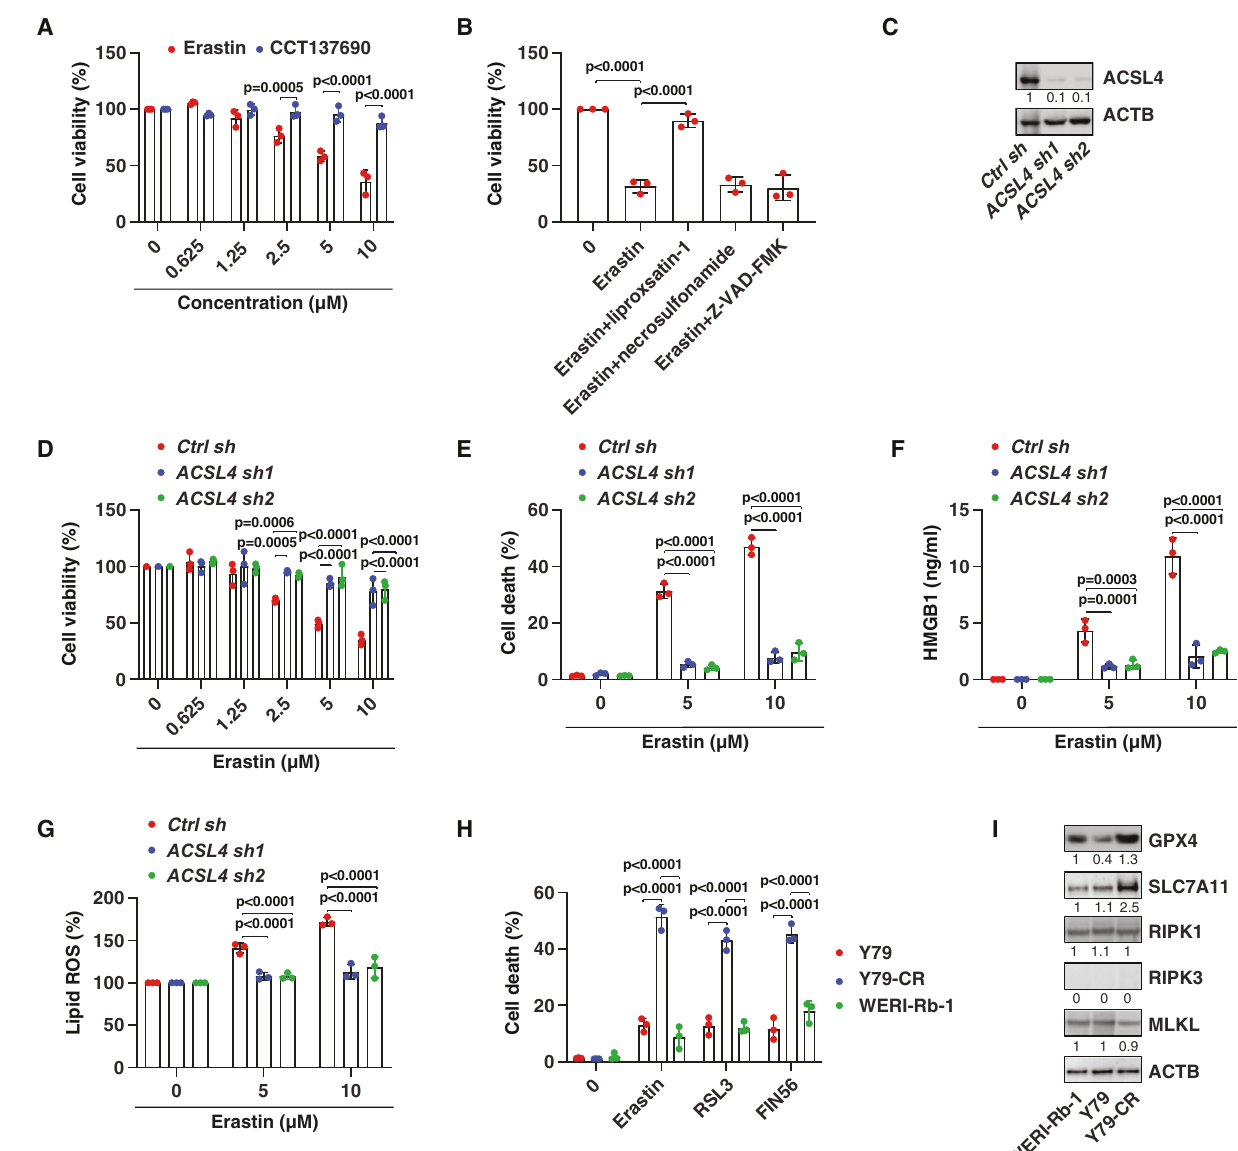
Fig. 2 Induction of ferroptosis eliminates drug-resistant cells. A Y79-CR cells were treated with erastin (0.625 – 10 µM) or CCT137690 (0.625 – 10 µM) for 24 h, and cell viability was assayed (two-way ANOVA with Tukey ’ s multiple comparisons test; data are presented as mean ± SD; n = 3 biologically independent samples). B Y79-CR cells were treated with erastin (10 µM) in the absence or presence of liproxsatin-1 (1 µM), necrosulfonamide (1 µM), or Z-VAD-FMK (10 µM) for 24 h, and cell viability was assayed (two-way ANOVA with Tukey ’ s multiple comparisons test; data are presented as mean ± SD; n = 3 biologically independent samples). C Western blot analysis of protein expression in control and ACSL4 -knockdown Y79-CR cells. D Cell viability analysis of the indicated Y79-CR cells following treatment with erastin (0.625 – 10 µM) for 24 h (two-way ANOVA with Tukey ’ s multiple comparisons test; data are presented as mean ± SD; n = 3 biologically independent samples). E – G The indicated Y79-CR cells were treated with erastin (5 – 10 µM) for 24 h, and then cell death ( E ), HMGB1 release ( F ), and lipid ROS ( G ) were assayed (two-way ANOVA with Tukey ’ s multiple comparisons test; data are presented as mean ± SD; n = 3 biologically independent samples). H The indicated human RB cells were treated with erastin (10 µM), RSL3 (1 µM), or FIN56 (1 µM) for 24 h, and cell death was assayed (two-way ANOVA with Tukey ’ s multiple comparisons test; data are presented as mean ± SD; n = 3 biologically independent samples). I Western blot analysis of protein expression in the indicated human RB cell lines. downregulated by 4OI (Fig. 5B), supporting the concept that 4OI 2 weeks). Consistent with our in vitro data (Fig. 4M), 4OI showed can trigger ferritinophagy for the degradation of ferritin. In contrast, greater anticancer activity in Y79-CR cells than in Y79 cells (Fig. 5A). administration of 4OI in mice had no signi fi cant effect on the activity Subsequent analysis of MAP1LC3B-II protein expression (Fig. 5B), free of CASP3 (caspase 3) in isolated tumor tissues (Fig. 5F), indicating that iron levels (Fig. 5C), and malondialdehyde (MDA, one of the fi nal 4OI-mediated tumor suppression is independent of caspase- products of lipid peroxidation [54]) (Fig. 5D) in tumors as well as mediated apoptosis. serum HMGB1 (Fig. 5E) at day 21 after treatment suggested that 4OI- We also monitored liver and kidney functions by measuring the treated Y79-CR cells had higher levels of autophagic and ferroptotic serum levels of GPT/ALT (glutamic--pyruvic transaminase) and responses. Accordingly, the protein expression of FTH1 was